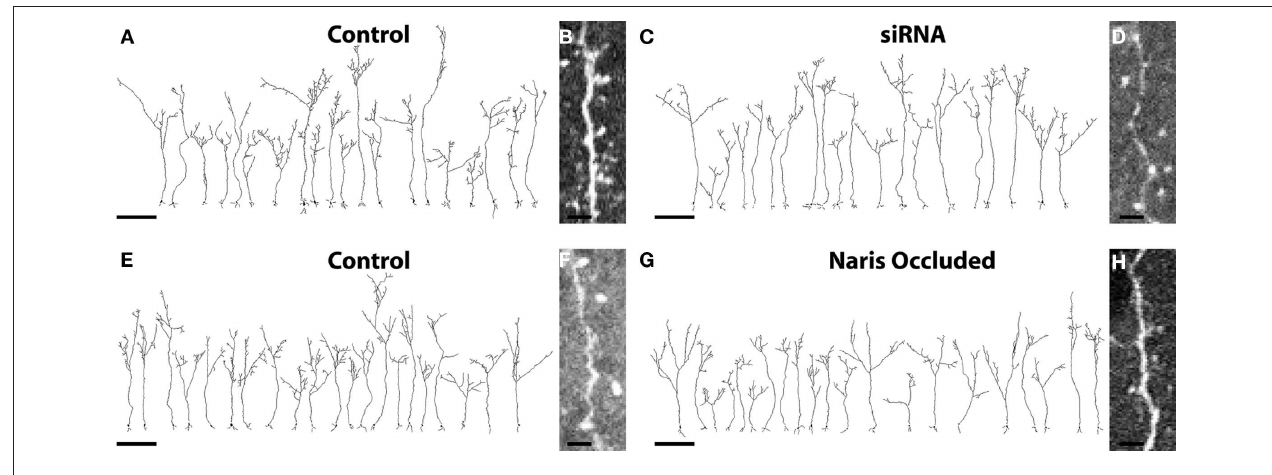
Figure 2 | Complete cellular reconstructions of randomly selected egFP + ABNs. (A,C) Group 1 cells; four animals, five cells per hemisphere, n = 20 per condition. Scale bar, 100 μm. (B,D) Raw image of dendrite and spines taken from image stacks of control and siRNA cells respectively. Scale bar, 5 μm.